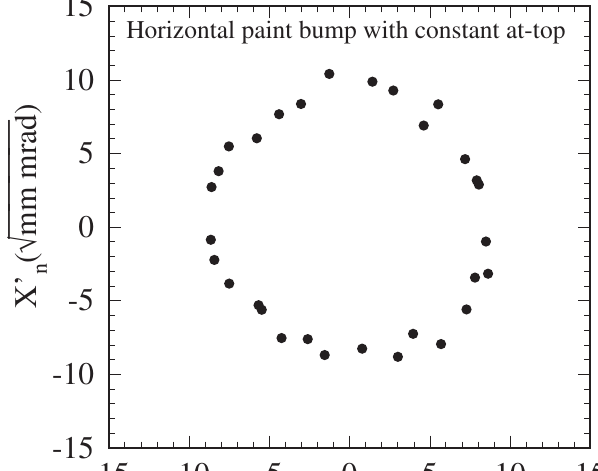
TABLE I. Numerical results of the reconstructed phase space coordinates at the injection point for a painting area of 100 (cid:1) mm mrad in the horizontal and vertical directions after calibration of the top excitation levels of the paint bump mag- nets. The paint bump magnets were excited with constant at the top for the desired painting area given as by ‘‘Target,’’ where the phase space coordinates at the injection point had been recon- structed utilizing Eq. (13). The results obtained with both pairs were in good agreement and were also basically consistent with direct measurements made using the MWPMs. After the paint bump top excitation level had been efficiently calibrated, the decay wave forms of the magnetic field as a function of time were then easily made. FIG. 6. Normalized phase space plots of the central trajectory of the circulating beam obtained from the turn-by-turn beam positions measured by a pair of BPMs over the first 30 turns. Measurement took place separately in the horizontal and vertical directions, as given in the upper and lower figures, respectively. The paint bump magnets were excited with constant at the top for a full painting area of 100 (cid:1) mm mrad . The emittance formed by the central trajectory of the circulating beam was expected to be 75 (cid:1) mm mrad . As expected, each of the phase space plots was circular, and the emittances formed by the central trajecto- ries of the circulating beam were then calculated from the area ( (cid:2) 1 : 0 , (cid:2) 2 : 01 ) Eq. (13) with pair of the circles and found to be 78 : 8 (cid:7) 2 : 1 and 74 : 8 (cid:7) 2 : 1 (cid:1) mm mrad in the horizontal and vertical directions, respec- tively.